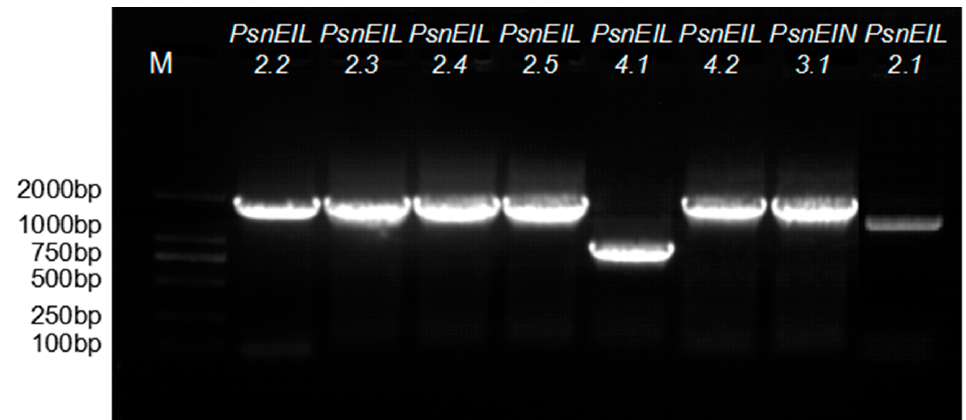
Figure 1. The products of PCR amplification of PsnEIN3/EIL gene. The arrow on the left is the band size of the electrophoresis marker. Electrophoresis bands from left to right: DL2000Marker(M); gel electrophoresis imaging bands of PsnEIL2.2 , PsnEIL2.3 , PsnEIL2.4 , PsnEIL2.5 , PsnEIL4.1 , PsnEIL4.2 , PsnEIN3.1 , and PsnEIL2.1 . The lengths of the PsnEIN3/EIL genes were 1980, 1989, 1989, 1962, 1197, 1788, 1854, and 1539 bp.